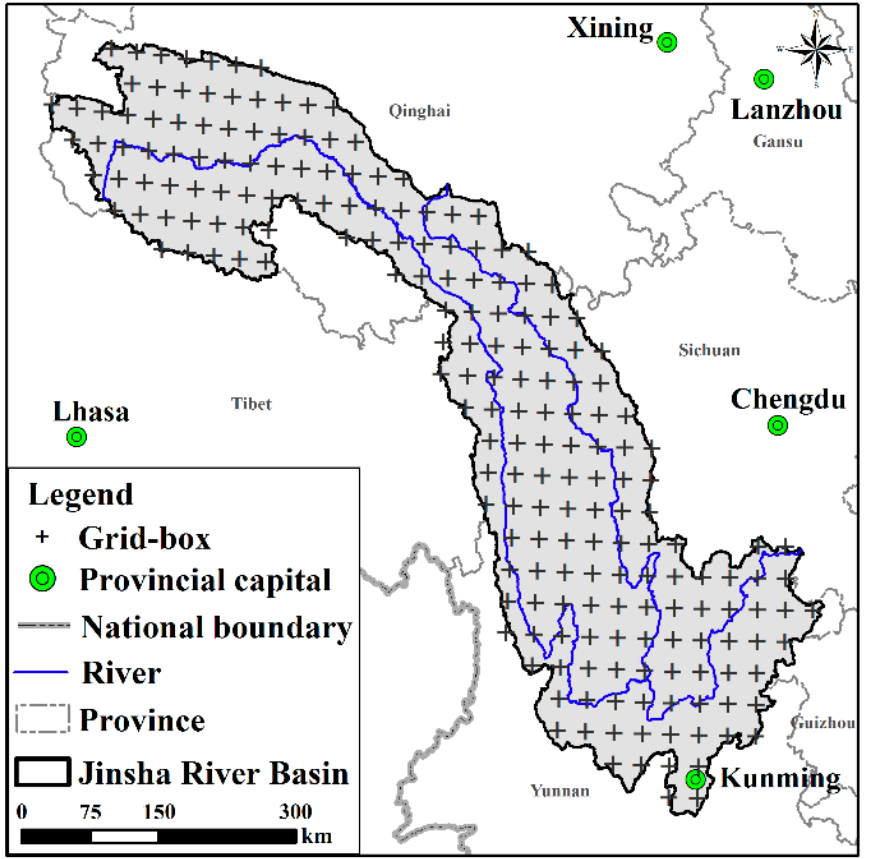
Figure 8. Locations of major cities and hydrological stations along the Jinsha River.